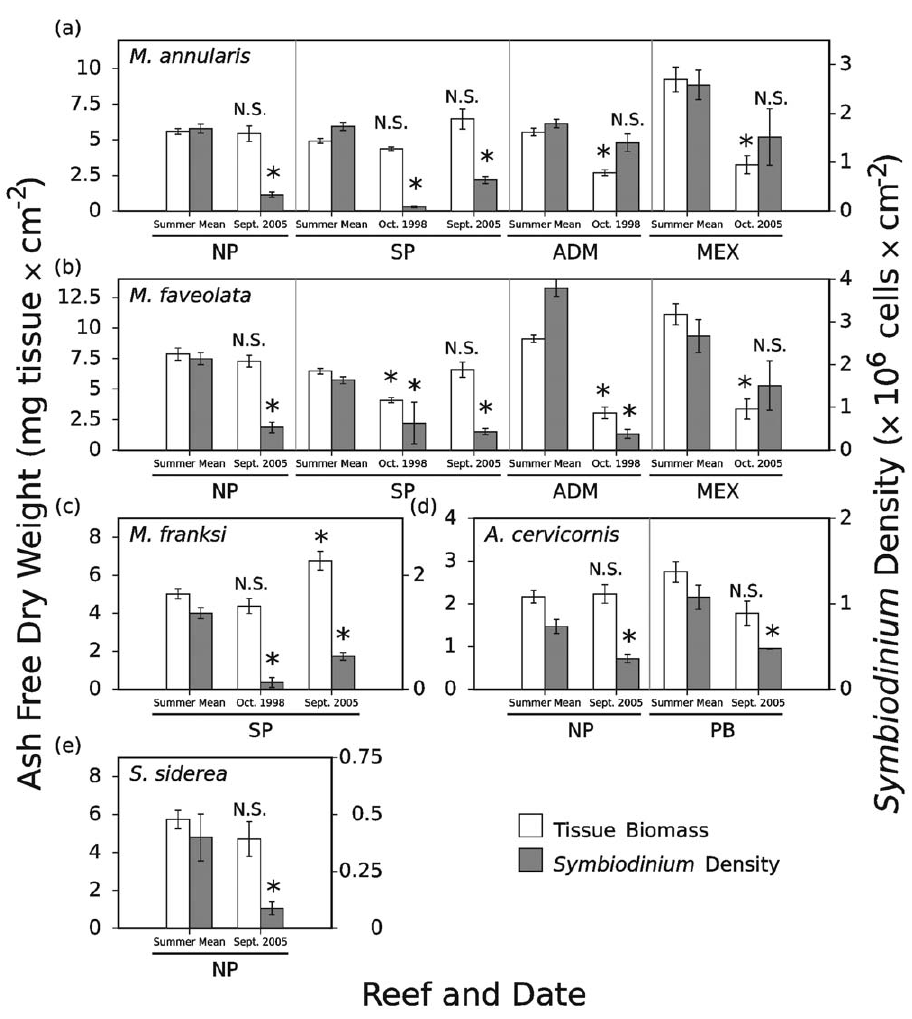
Figure 6. Changes in Symbiodinium density and tissue biomass coinciding with bleaching events for five coral species. Data are presented as mean values of tissue biomass (left axis and white bars) and Symbiodinium density (right axis and shaded bars) 6 standard error. Significant deviation from the mean summer tissue biomass and Symbiodinium density, as evaluated using T-tests, indicated above the histograms for each species (N.S.=no significant difference, *=significant deviation from the summer mean at a =0.05). Reef abbreviations provided in Fig. 1. Note that bleaching impacts are not provided for certain coral species due to either a lack of sampling during the bleaching events (e.g., certain corals from the Florida Keys during the 1998 bleaching) or due to a lack of visible and statistically significant bleaching for that species and location (e.g., A. palmata from all regions in 2005).